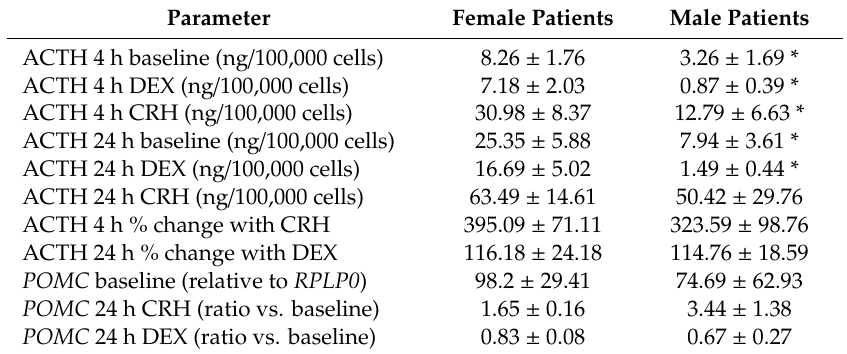
Table 1. Secretory pattern in adenomas from female and male patients with Cushing’s